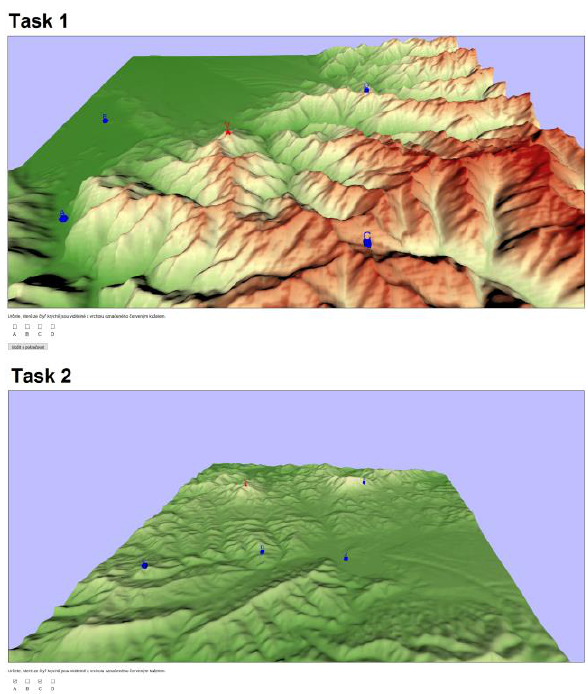
Fig. 2. Screenshots from testing tasks 1 and 2. Assignments: Determine which of the four cubes (A – B – C - D) are visible from the top marked with red cone.